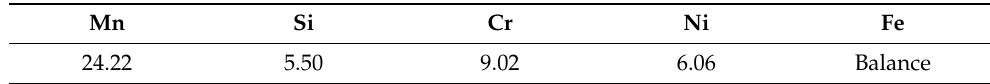
Table 1. Alloy chemical composition (in wt%).